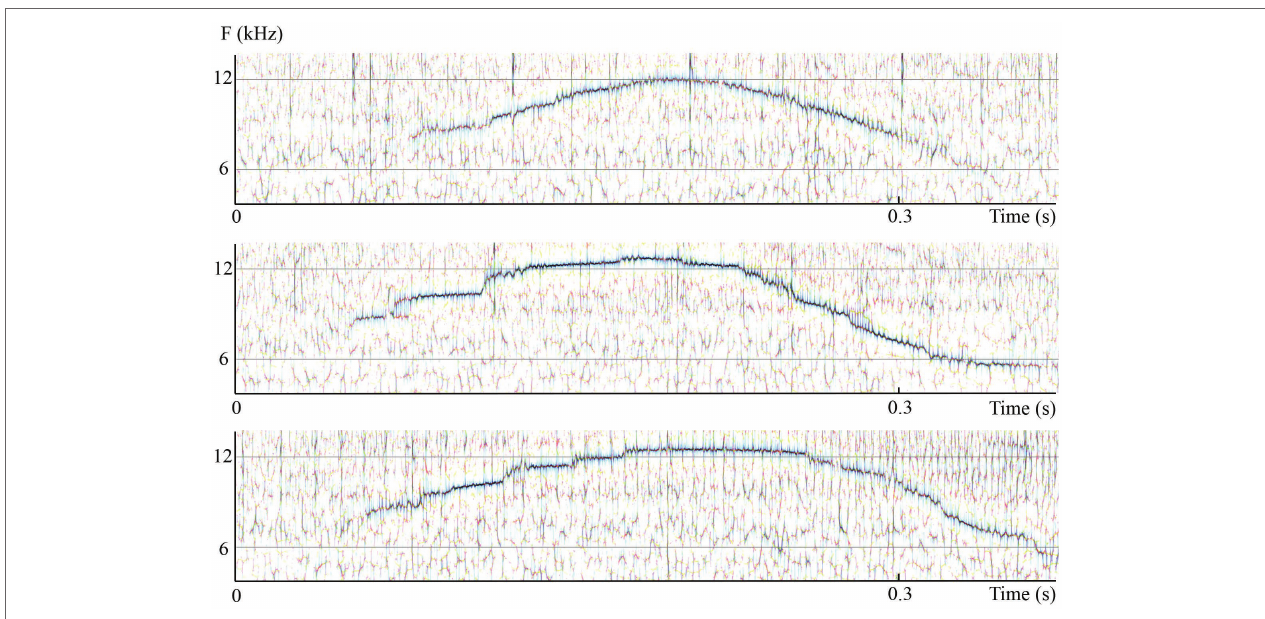
FIGURE 6 | High-resolution consensus reassigned spectrograms of sound data captured at open sea in Bimini from wild Atlantic spotted dolphins shows three individual elements or up/down frequency modulations of a dolphin whistle presented as three subpanels. Notice the many subtle differences between them. Chief among them is the breaking of the second and third element into “steps,” which causes the whistle, if played back at a substantially reduced speed and pitch, to sound more like little “arpeggios” than smooth glides. Panels display multiband-wavelet reassigned spectrograms: temporal resolution, 12 pixels/ms; frequency resolution, 1/40th of a semitone per pixel. (Recordings and edition by Marcelo Magnasco, listen to the three sound extracts as they were recorded in the wild in Bahamas. The original recording available online in Reiss and Magnasco (2021) is 1.5 s long and contains the 3 whistles represented in the high-resolution spectrograms and multiple clicks and a squawk of Stenella frontalis ).